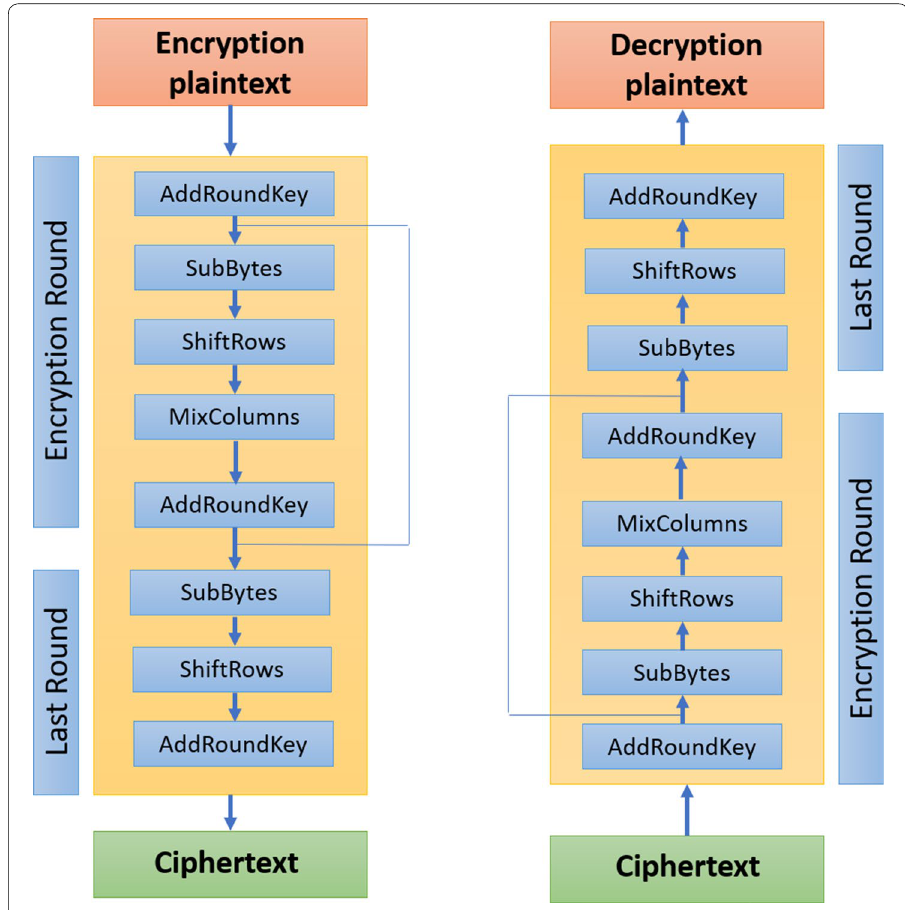
Fig. 4 The encryption-decryption procedures of the Advanced Encryption Standard